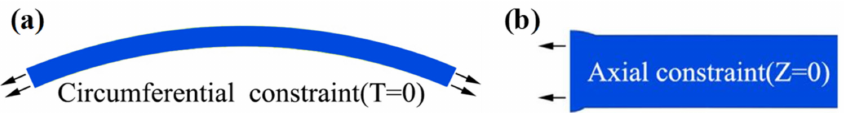
Figure 6. Stress field boundary conditions: ( a ) circumferential constraint, ( b ) axial